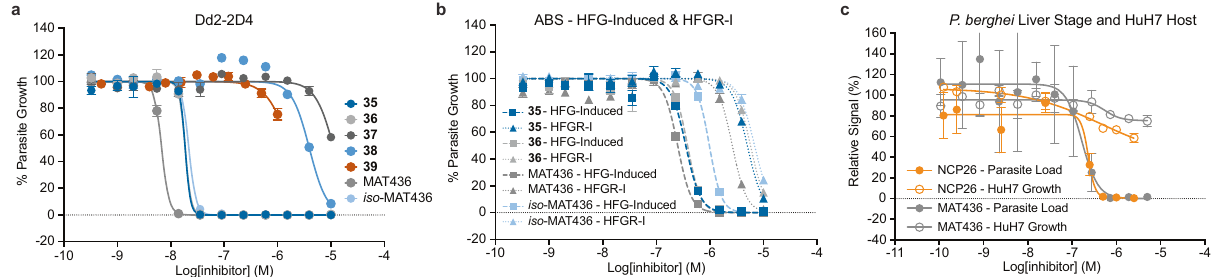
Fig. 6 | Cellular activities of triple-site ProRS inhibitors. a In vitro activity of pyrazinamide-halofuginone hybrids and Boc-protected precursors against wild- type ABS P. falciparum Dd2-2D4. b In vitro activity of pyrazinamide-halofuginone hybrids against halofuginone-induced (HFG-Induced, squares and dashed lines) and HFGR-I (triangles and dotted lines) ABS P. falciparum . c In vitro activity of NCP26andMAT436againstliverstage P.berghei (solidcircles)andHuH7livercells (open circles). In a – c , inhibitors are color coded: 35 (dark blue), 36 (light gray), 37